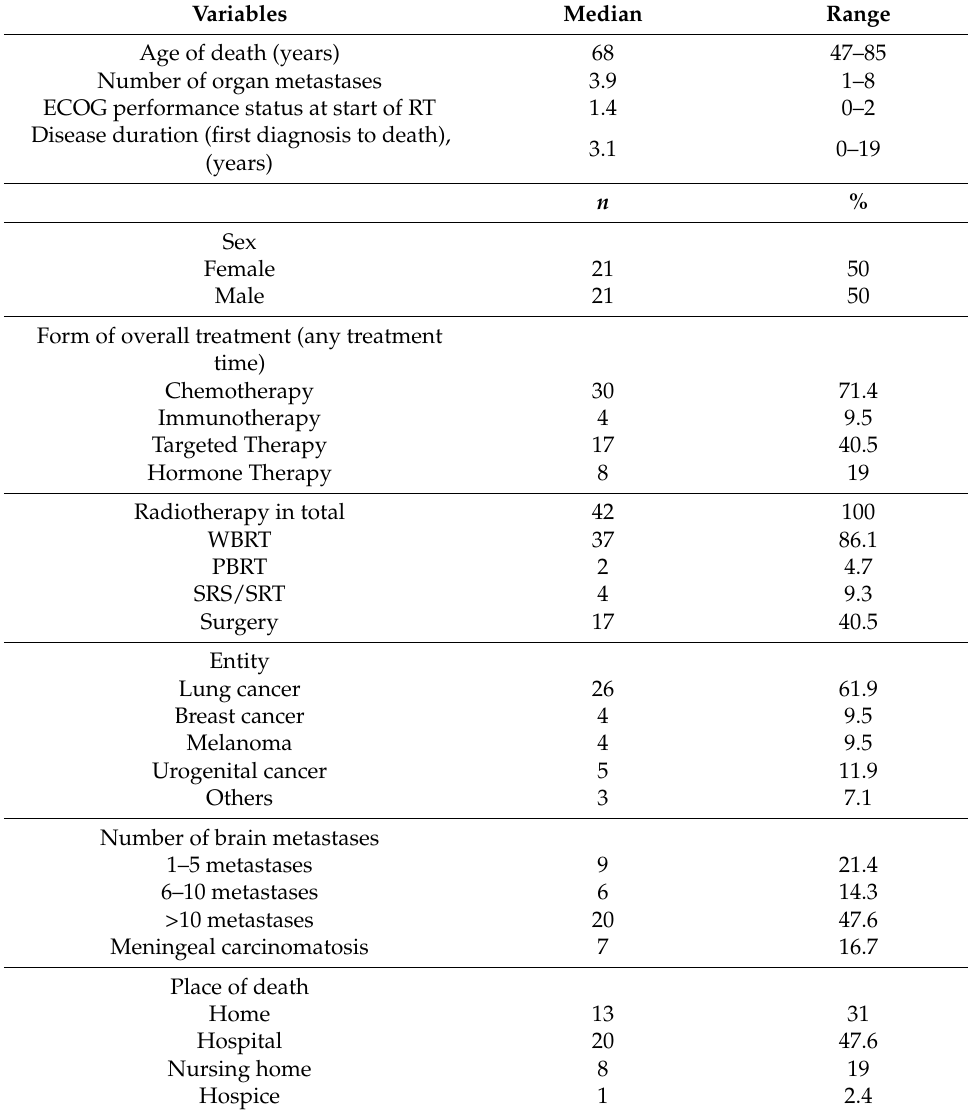
Table 1. Patients’ characteristics at the time of first diagnosis of brain metastases ( n = 42).